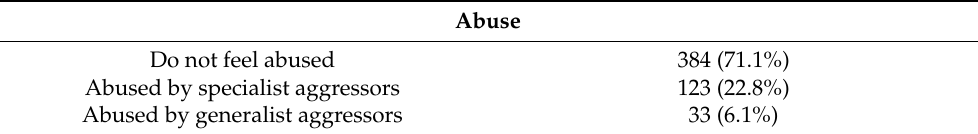
Table 5. Typology of self-perception of abuse.